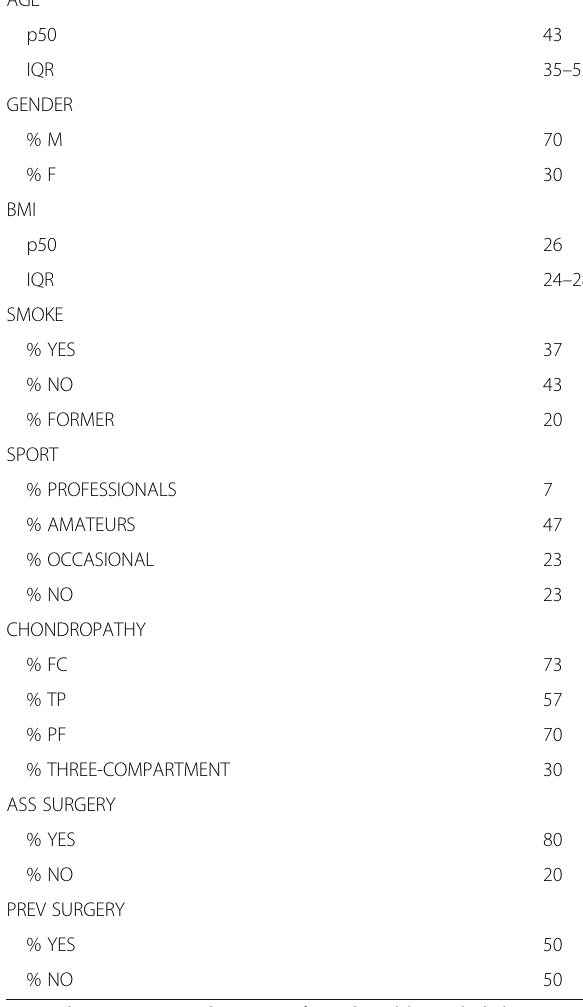
Table 1 Demographic characteristics of the population